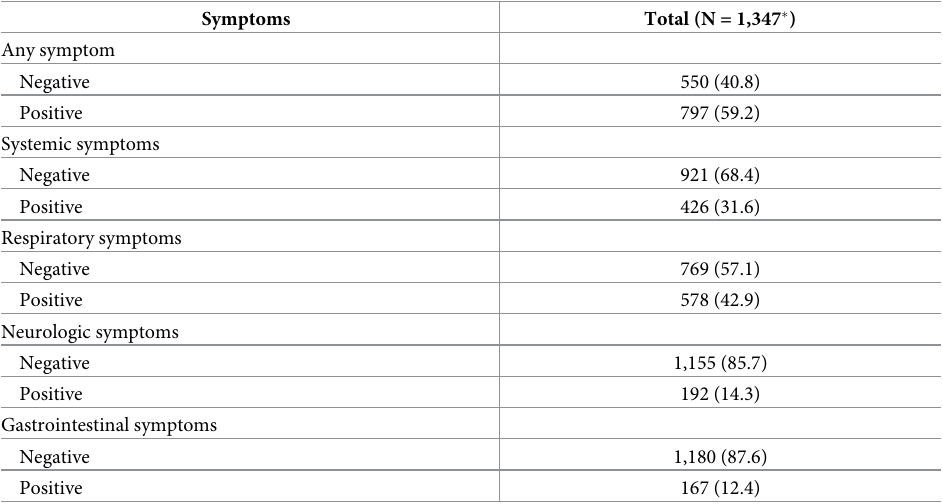
Table 2. Summary symptom screen results for COVID patients aged 18–29 years, diagnosed at a hospital